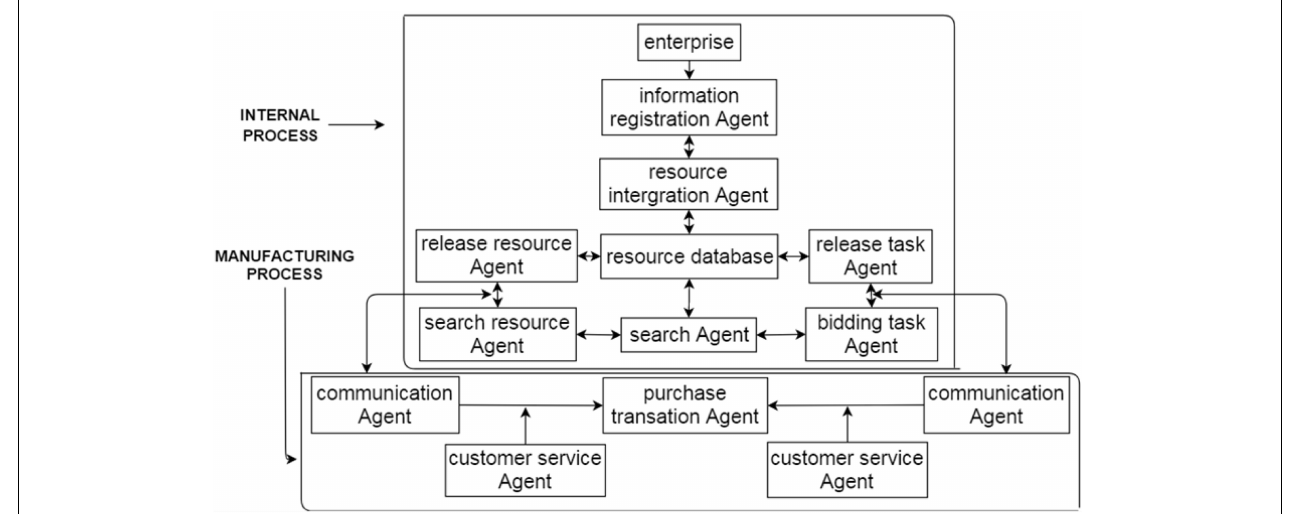
FIGURE 2 | Cloud service